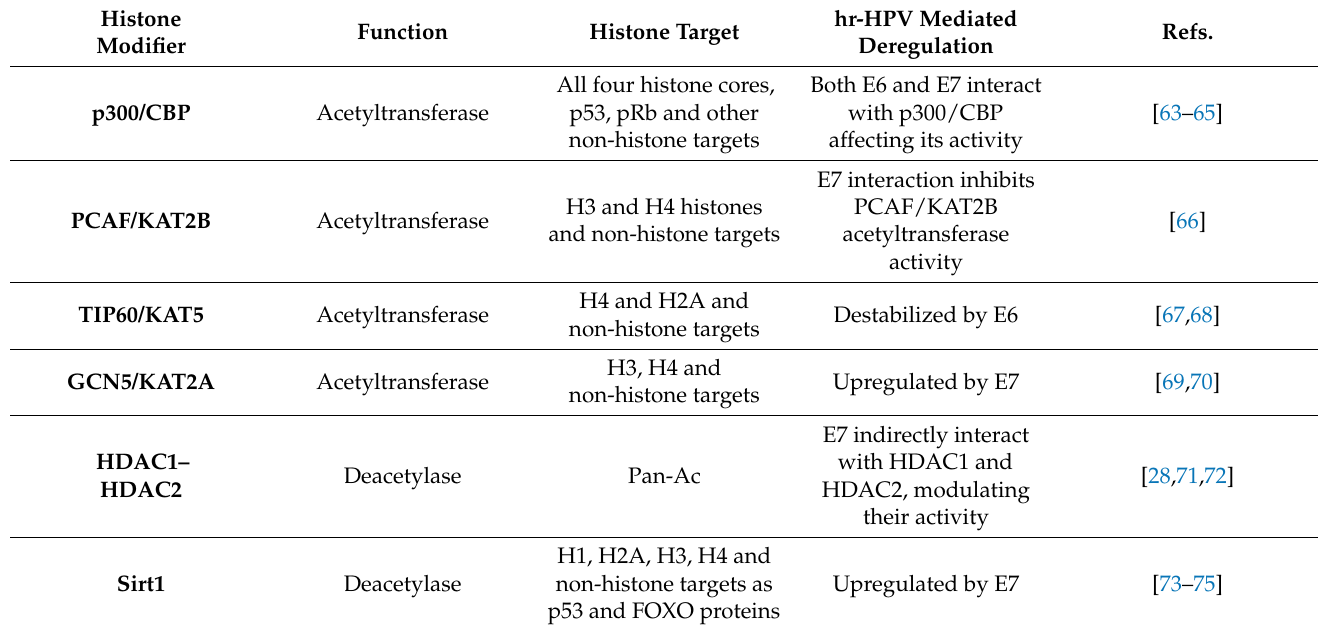
Table 3. Hr-HPV E6/E7-mediated regulation of some of the main histone modifiers responsible for the deposition or removal of acetylated